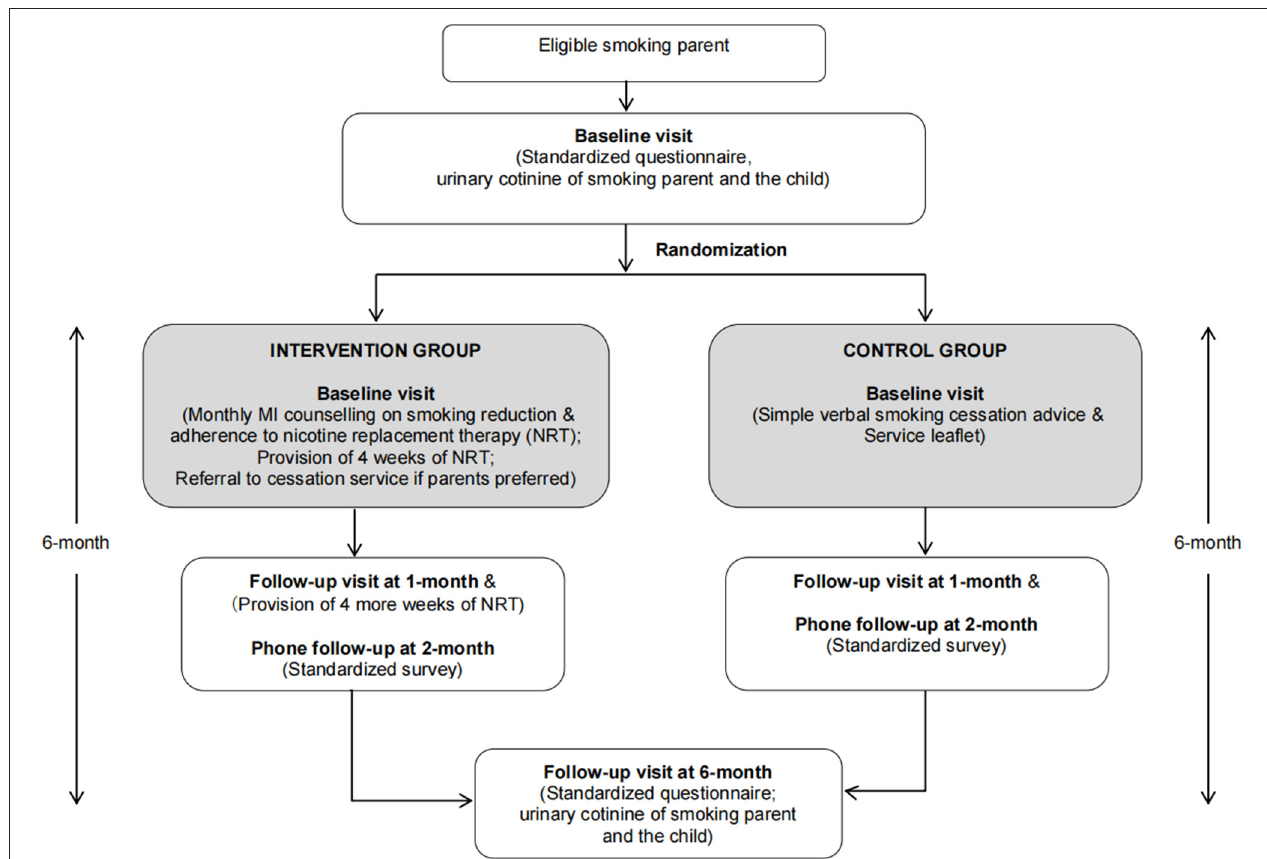
FIGURE 1 | Flow diagram of the study